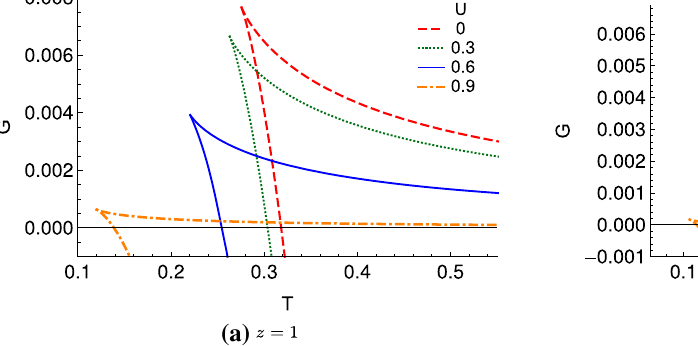
Fig. 3 The behavior of G versus T for linearly charged case with l = 1, b = 1 and n = 3